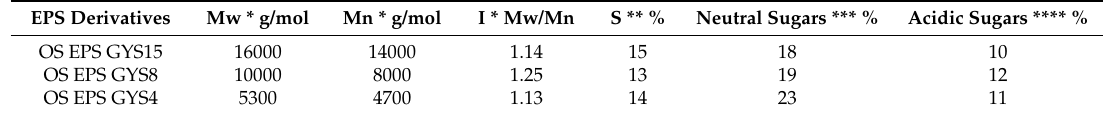
Table 1. Molecular weight and chemical composition of the oversulfated exopolysaccharide (OS-EPS) derivatives.